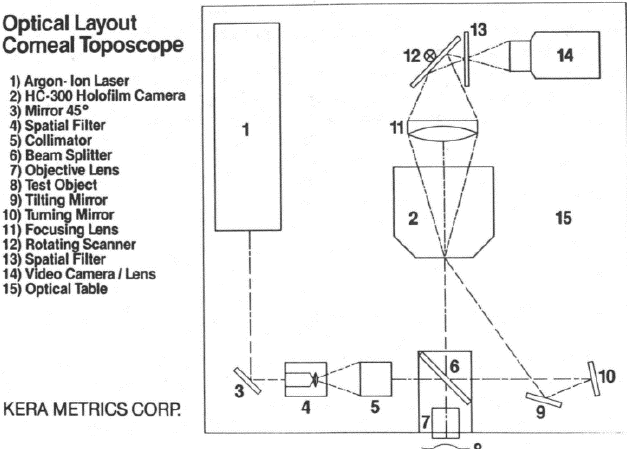
Figure 5. Two-wavelength holographic interferometer for contour evaluation of human corneas [53].